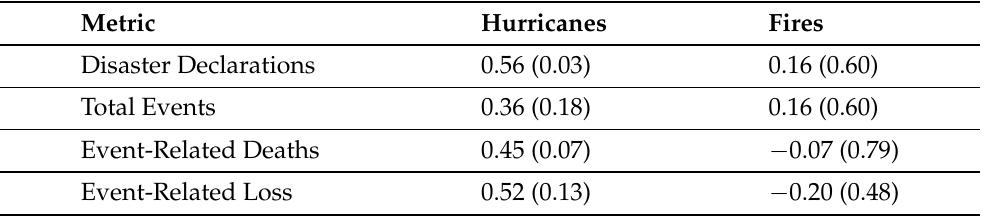
Table 1. Correlations between Coverage and Disaster Events. Analysis was conducted for 10 years, from 2008 to 2017. Values represent Kendall correlation values: τ , with p -values in